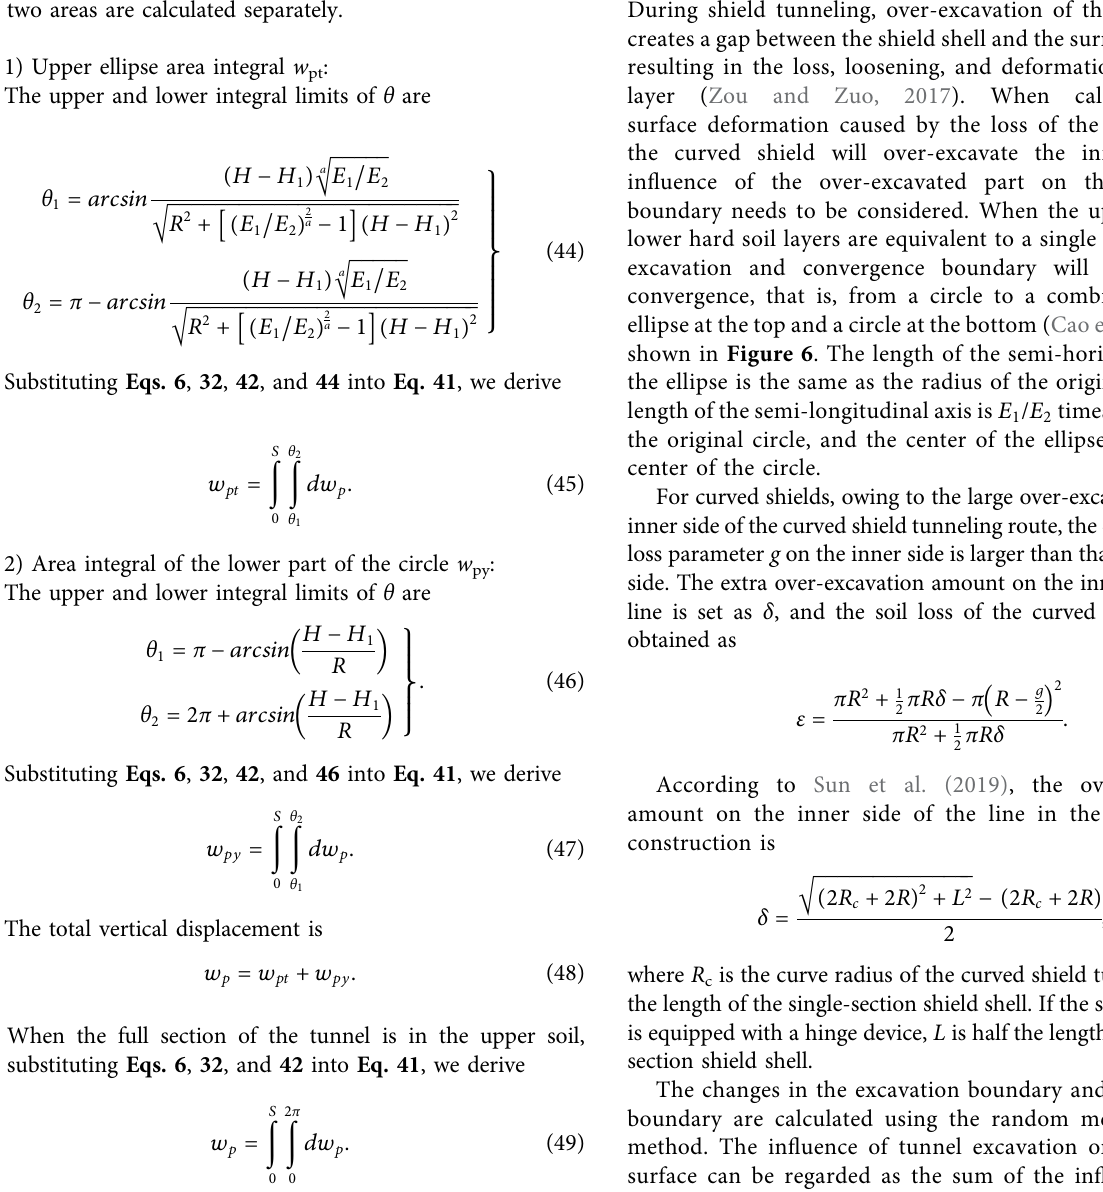
divided into an upper ellipse and a lower partial circle, and the two areas are calculated separately.